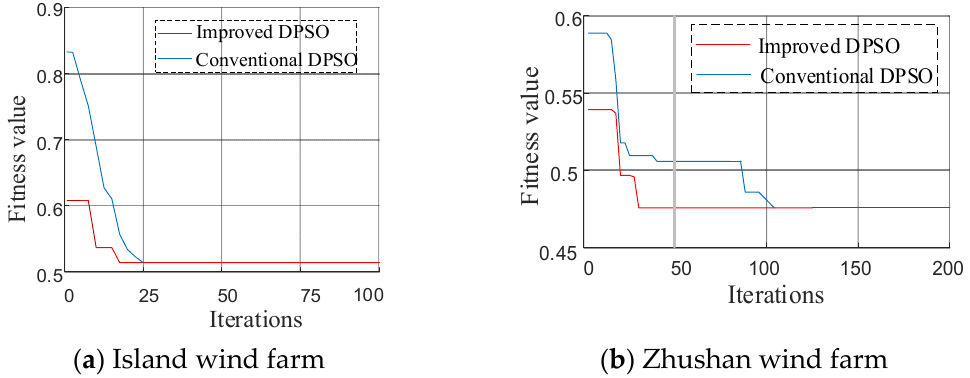
Figure 10. Optimal zoning result of Zhushan wind farm.